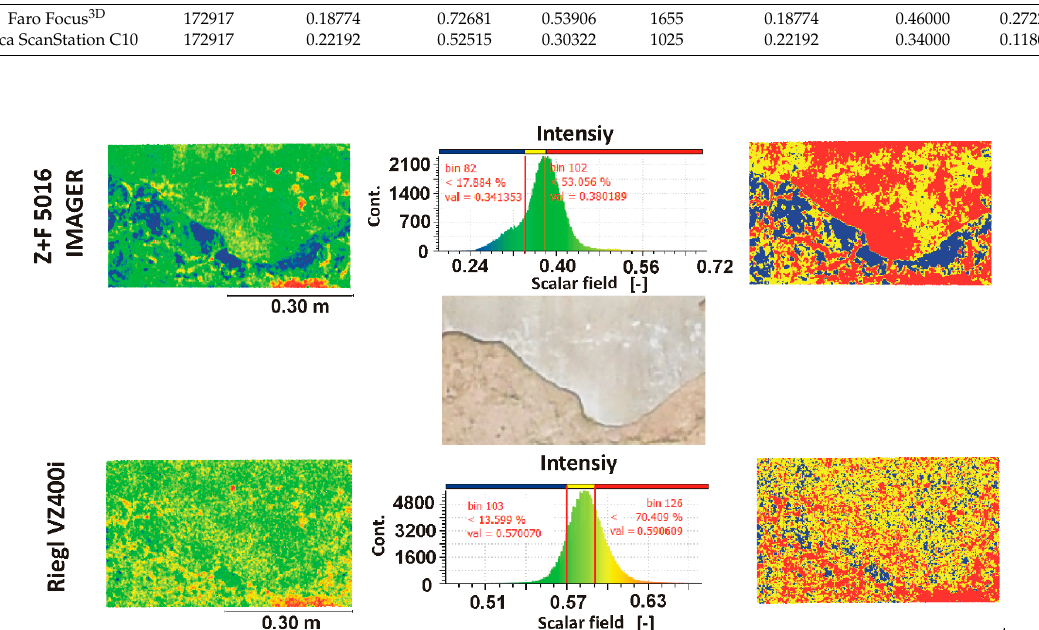
Figure 12. 2D damaged plaster mapping by point cloud classification.